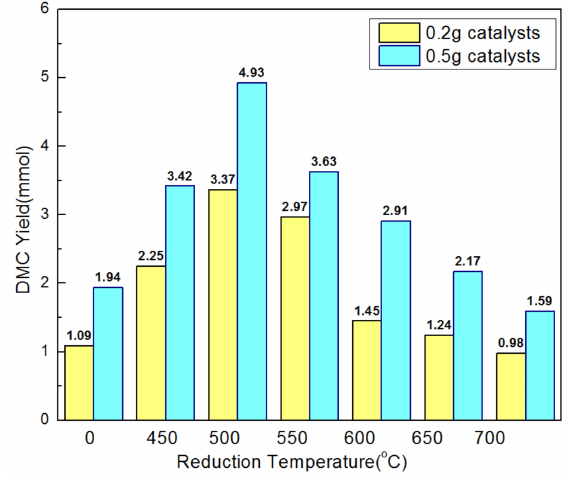
Figure 4. Effects of reduction temperature on the DMC yield over as-prepared nanowires. Reaction conditions: Methanol 500 mmol; catalysts 0.2 g or 0.5 g; CO 2 pressure 5 MPa; temperature 120 ◦ C; reaction time 5